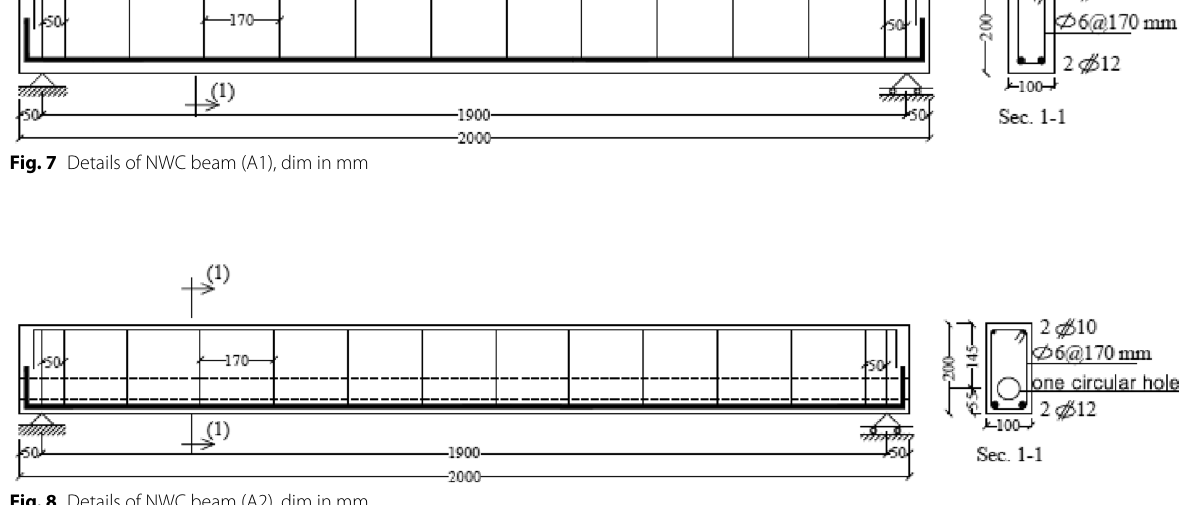
Fig. 8 Details of NWC beam (A2), dim in